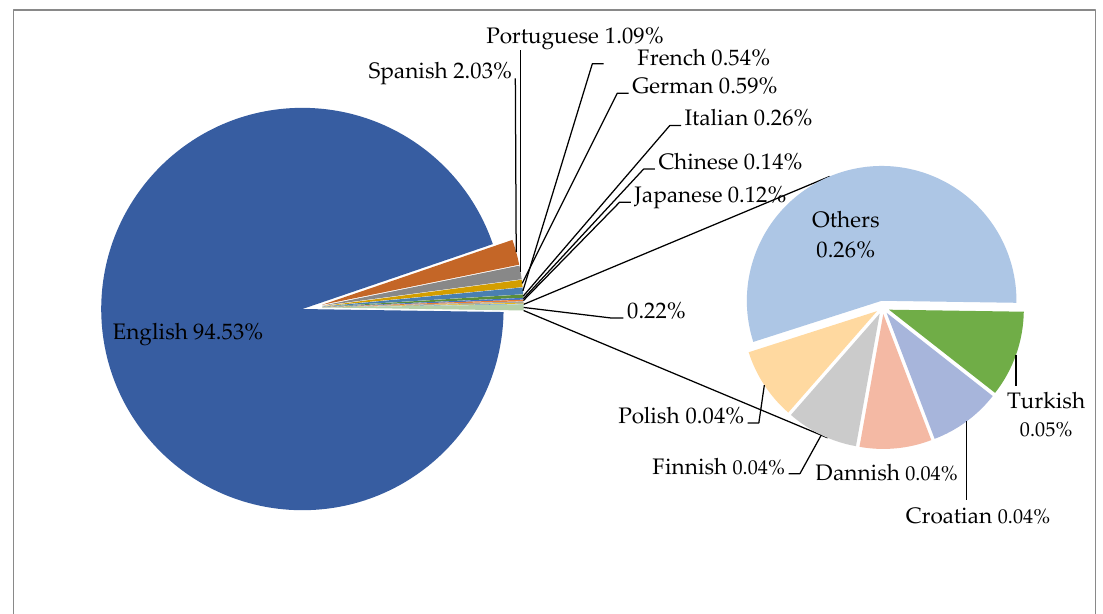
Figure 3. Languages of papers published over the period of 1978 to 2018.